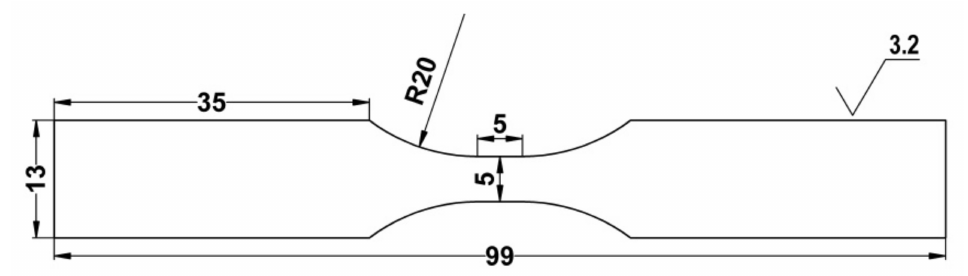
Figure 1. Illustration for dimensions of the fatigue test specimens (unit: mm).